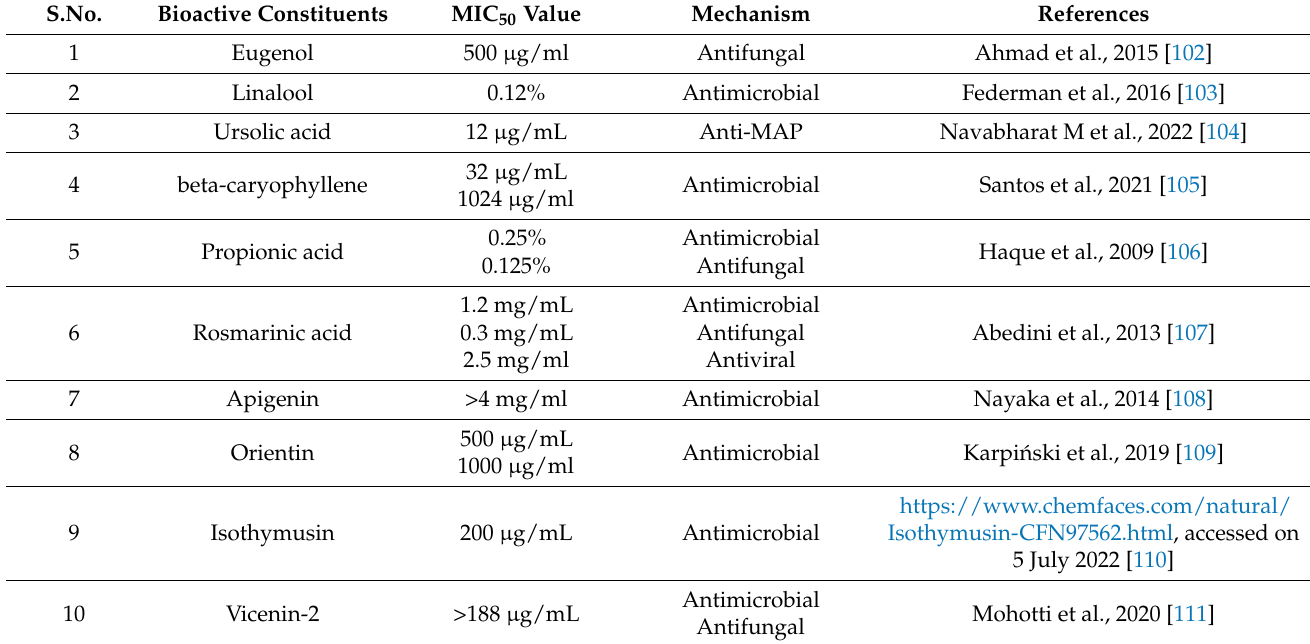
Table 1. Biological Mechanism between Bioactive constituents with MIC 50